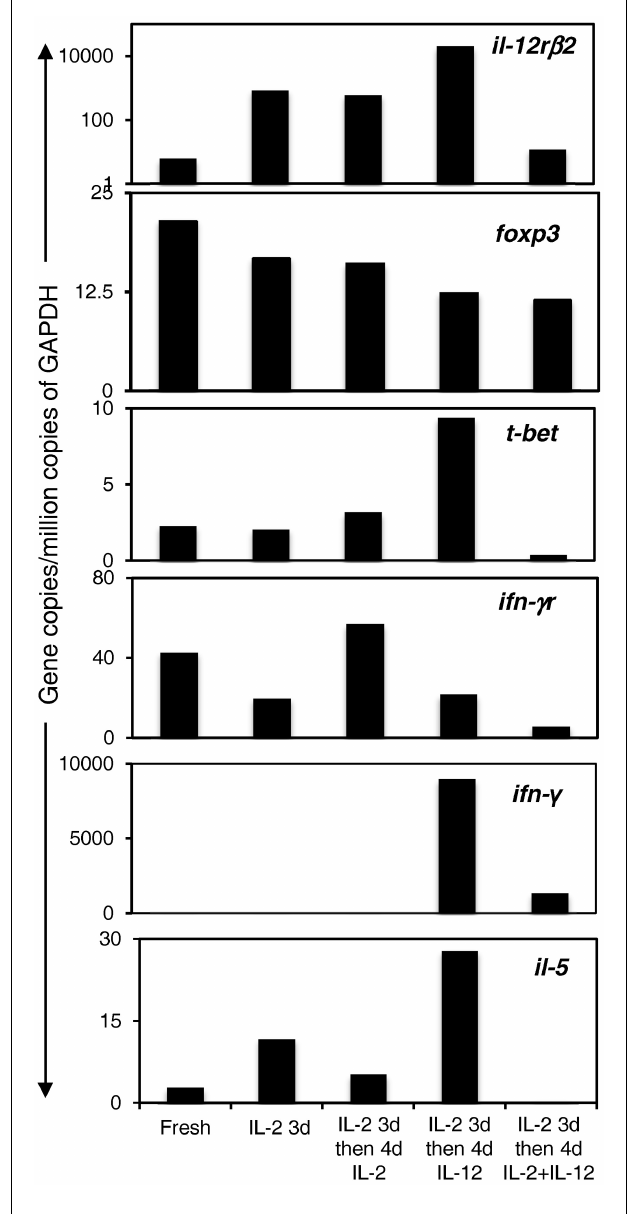
FIGURE 4 | Expression of transcription factor, cytokine, and cytokine receptor mRNA inTs1 cells re-cultured with alloantigen and either rIL-2, rIL-12p70, or both rIL-2 and rIL-12p70 .Ts1 cells re-cultured with alloantigen and either rIL-12p70 alone or rIL-2 and rIL-12p70 had high expression of foxp3 suggesting cells in all cultures wereTreg. il-12r β 2 levels were preserved in cultures with rIL-2 alone and rIL-12p70 alone but not those cultured with both rIL-2 and rIL-12p70. ifngr expression was enhanced with rIL-2, and was sustained with rIL-12p70 but not with both rIL-2 and rIL-12p70. il-5 expression was increased with rIL-12p70 but waned with rIL-2 and was lost with rIL-2 and rIL-12p70. Induction of t-bet , theTh1 transcription factor, and ifn- γ occurred after re-culture with rIL-12p70 alone, and not after re-culture with rIL-2 or both rIL-2 and rIL-12p70.Thus,Ts1 cells re-cultured with rIL-12p70 alone developed aTh1-likeTreg phenotype, while retaining foxp3 expression and the CD4 + CD25 + Foxp3 + phenotype. Re-culture ofTs1 cells with rIL-2 retained theTs1 phenotype. Re-culture of Ts1 cells with both rIL-2 and rIL-12p70 led to loss of theTs1 phenotype and did not induce aTh1-likeTreg